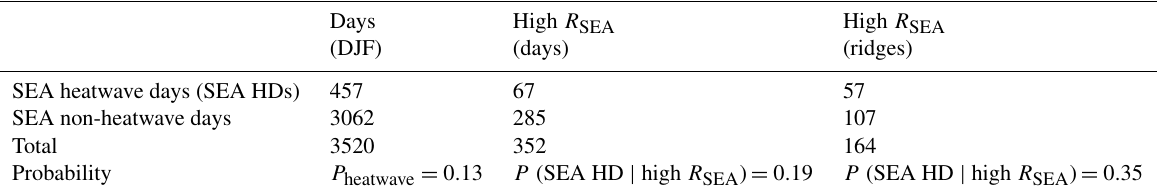
Table C1. Occurrence of high R SEA on SEA heatwave days and the associated conditional probabilities of a heatwave given high R SEA , where high R SEA (ridges) in the last column is calculated from taking the 90th percentile only from the days in DJF having an anticyclonic PV anomaly over SEA (30–45 ◦ S, 130–153 ◦ E).